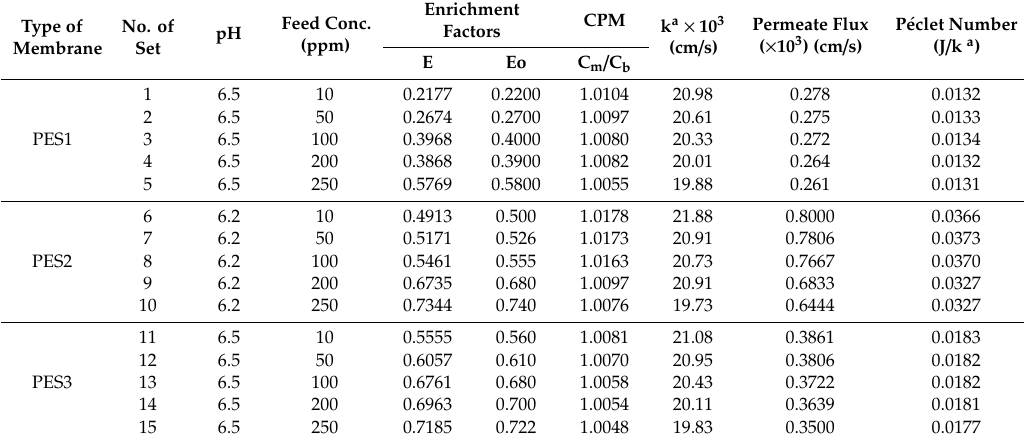
Table 6. Summary of CPM, enrichment factors (Eo and E), and P é clet number (Cd 2 + ). Type of No. of Membrane